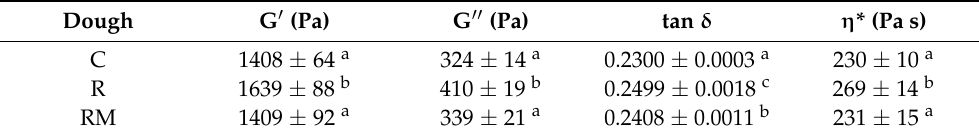
Table 1. Rheological parameters of the doughs (C, control; R, rosehip; RM, encapsulated rosehip).